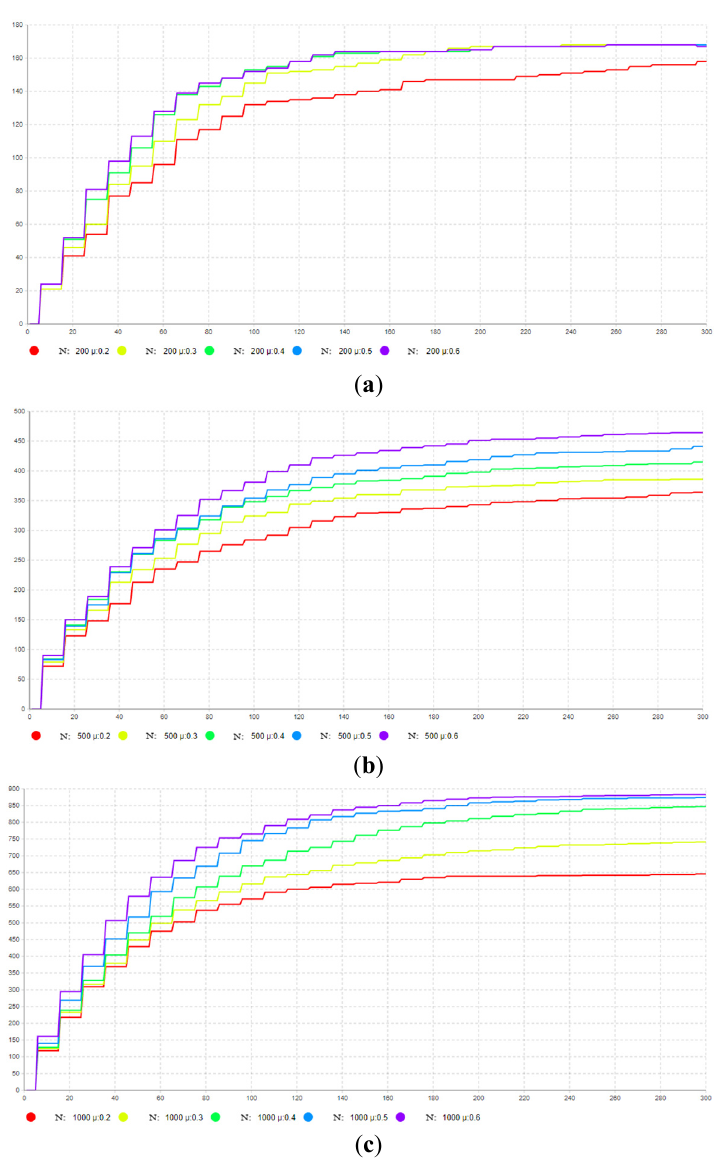
Figure 3. Influence of CID on BCW under different communication intensities.